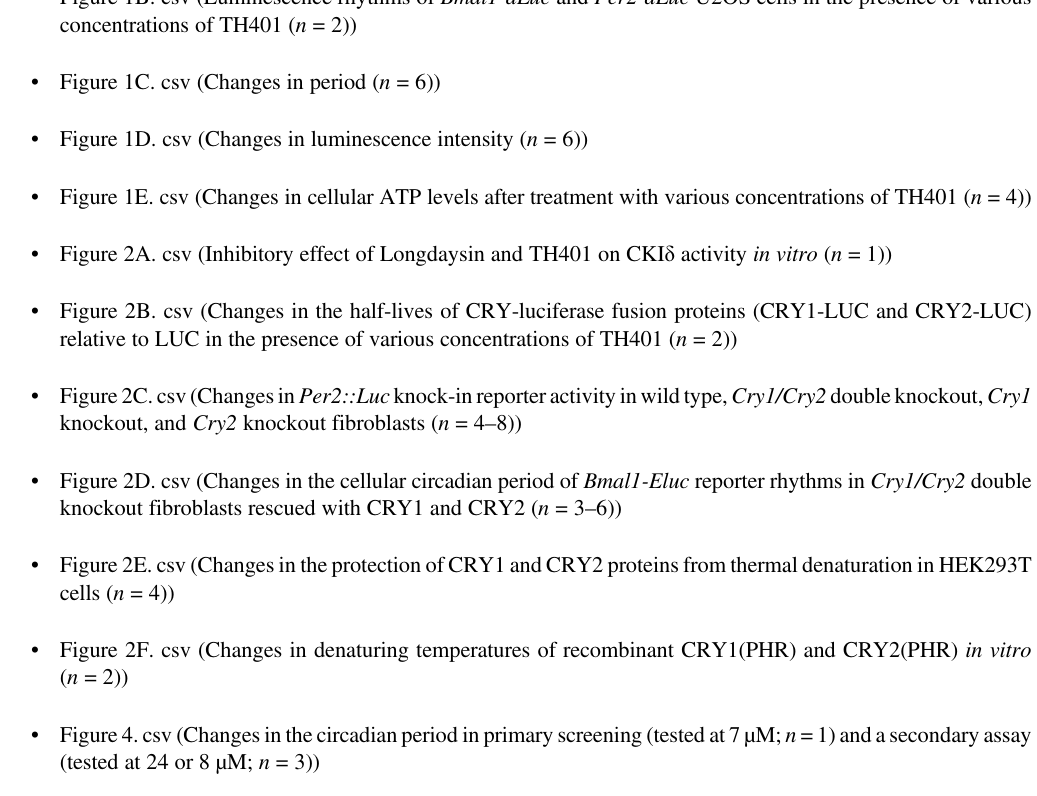
(cid:129) Figure 1B. csv (Luminescence rhythms of Bmal1-dLuc and Per2-dLuc U2OS cells in the presence of various concentrations of TH401 ( n = 2)) (cid:129) Figure 1C. csv (Changes in period ( n = 6)) (cid:129) Figure 1D. csv (Changes in luminescence intensity ( n = 6)) (cid:129) Figure 1E. csv (Changes in cellular ATP levels after treatment with various concentrations of TH401 ( n = 4)) (cid:129) Figure 2A. csv (Inhibitory effect of Longdaysin and TH401 on CKI δ activity in vitro ( n = 1)) (cid:129) Figure 2B. csv (Changes in the half-lives of CRY-luciferase fusion proteins (CRY1-LUC and CRY2-LUC) relative to LUC in the presence of various concentrations of TH401 ( n = 2)) (cid:129) Figure 2C.csv(Changesin Per2::Luc knock-in reporteractivity inwildtype, Cry1/Cry2 doubleknockout, Cry1 knockout, and Cry2 knockout fibroblasts ( n = 4 – 8)) (cid:129) Figure 2D. csv (Changes in the cellular circadian period of Bmal1-Eluc reporter rhythms in Cry1/Cry2 double knockout fibroblasts rescued with CRY1 and CRY2 ( n = 3 – 6)) (cid:129) Figure 2E. csv (Changes in the protection of CRY1 and CRY2 proteins from thermal denaturation in HEK293T cells ( n = 4)) (cid:129) Figure 2F. csv (Changes in denaturing temperatures of recombinant CRY1(PHR) and CRY2(PHR) in vitro ( n = 2)) (cid:129) Figure 4. csv (Changes in the circadian period in primary screening (tested at 7 μ M; n = 1) and a secondary assay (tested at 24 or 8 μ M; n =